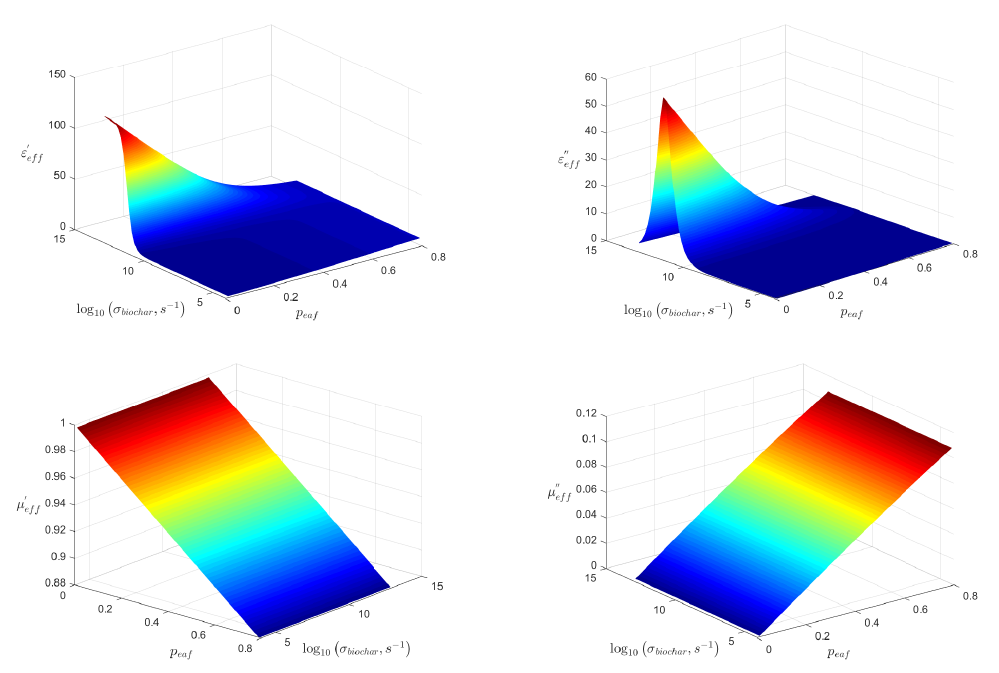
Figure 4. Real and imaginary parts of the effective permittivity ε (cid:48) and ε (cid:48)(cid:48) and permeability µ (cid:48) and µ (cid:48)(cid:48) of EAF dust–biochar powder mixture depending on the volume fraction of EAF dust ν eaf and biochar conductivity σ biochar .